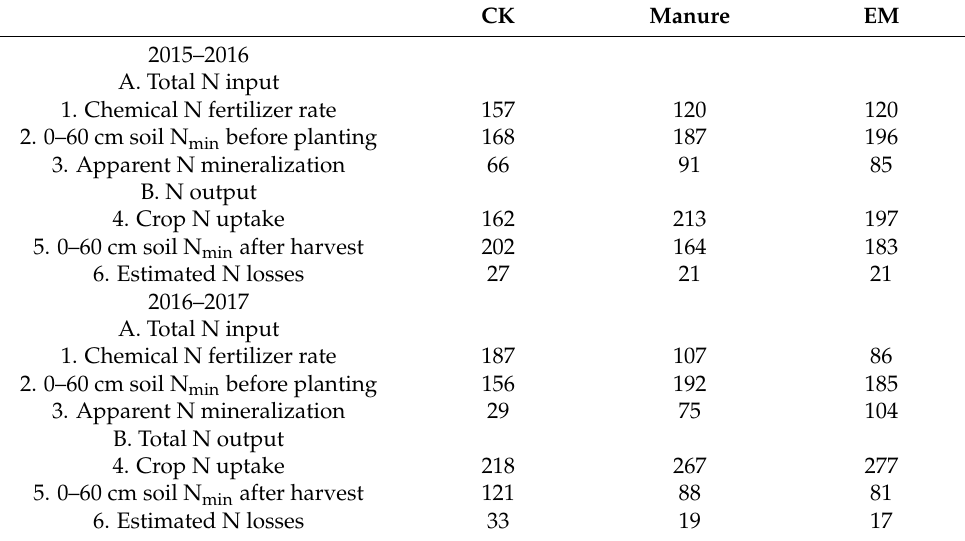
Table 5. Calculated apparent N mineralization, estimated N losses for three treatments